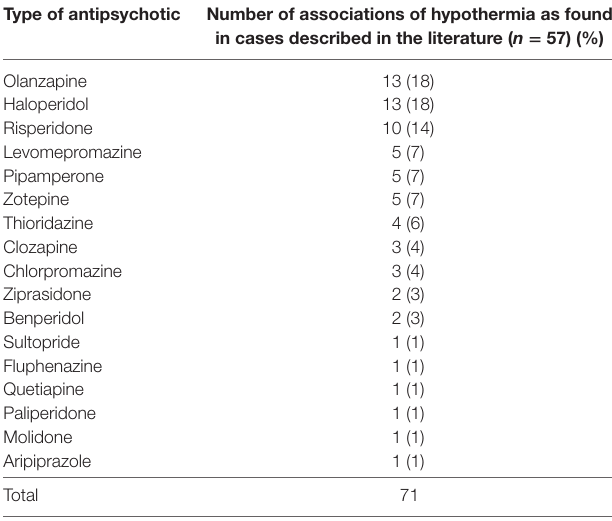
taBLe 4 | Antipsychotics and number of associations with hypothermia. taBLe 3 | Demographic and clinical characteristics of cases of hypothermia